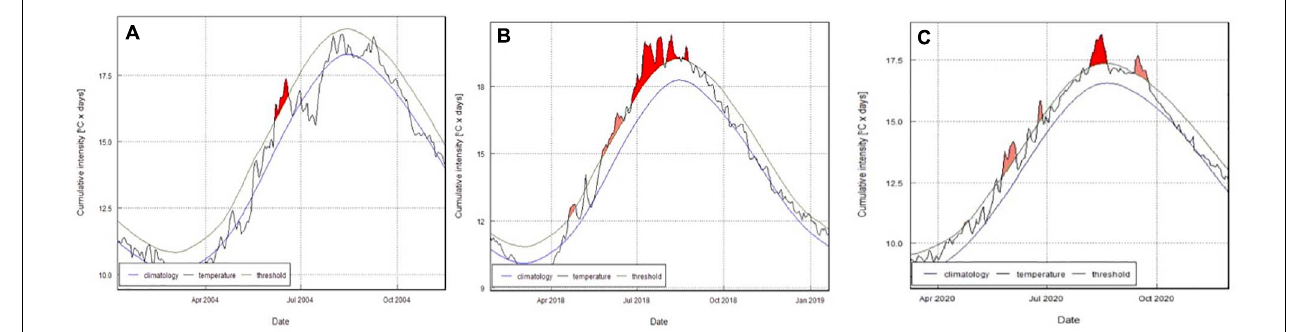
FIGURE 3 | (A) Heat damaged Pelvetia canaliculata , 2018. (B) heat damaged Fucus spiralis , 2018.